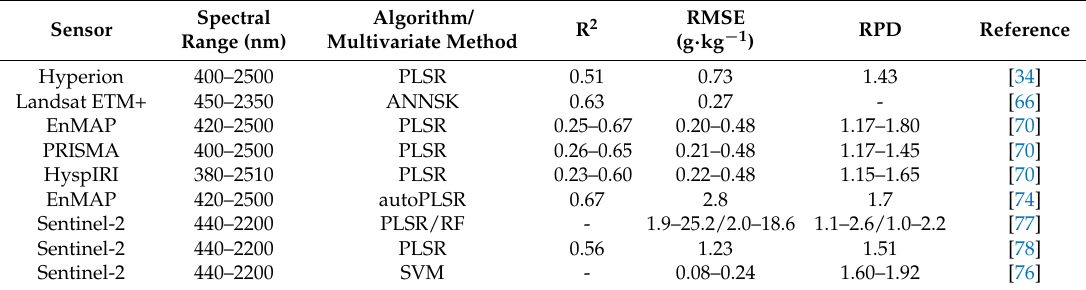
Table 1. Studies for SOC estimation with the use of space borne